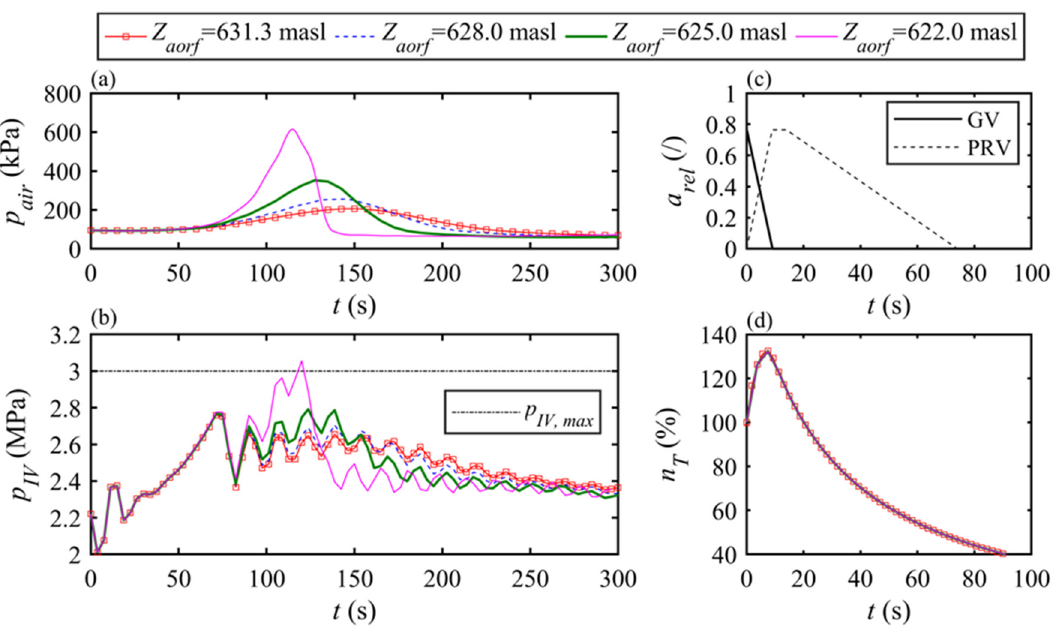
Figure 9. Vertical positioning of the aeration orifice at 631.3; 628.0; 625.0; 622.0 m a.s.l. ( a ) air pressure in the SPTCST, ( b ) pressure on turbine inlet valve, ( c ) closing/opening law of guide vanes/PRV and ( d ) transient turbine revolving speed.